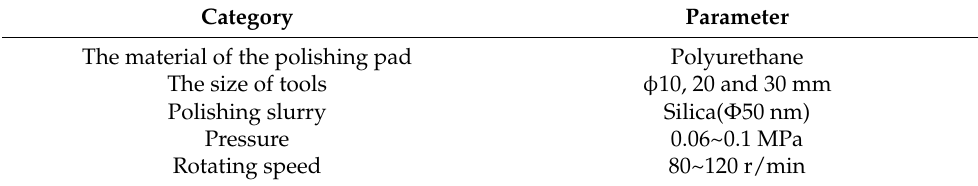
Table 1. Experimental